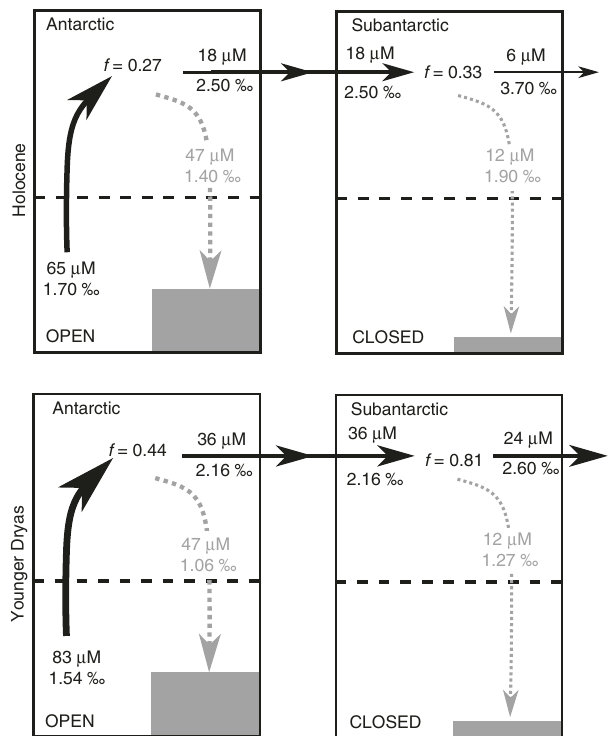
Fig. 4 Solutions to the mass balance model for Si cycling in the Southern Ocean during the Holocene (top) and Younger Dryas (bottom). In each of the reconstructions an open and closed isotope system models were applied to the Antarctic and Subantarctic, respectively. Black and grey arrows and text denote the transfer of DSi and opal, respectively. Bold data are those extracted from the literature and available data. The remaining data have been calculated from the simple mass balance model. The term, f, is the fraction of the available DSi pool remaining after utilization by diatoms. More details on the construction of this model can be found in Supplementary Note 5, along with the justi fi cation for the isotope system models applied